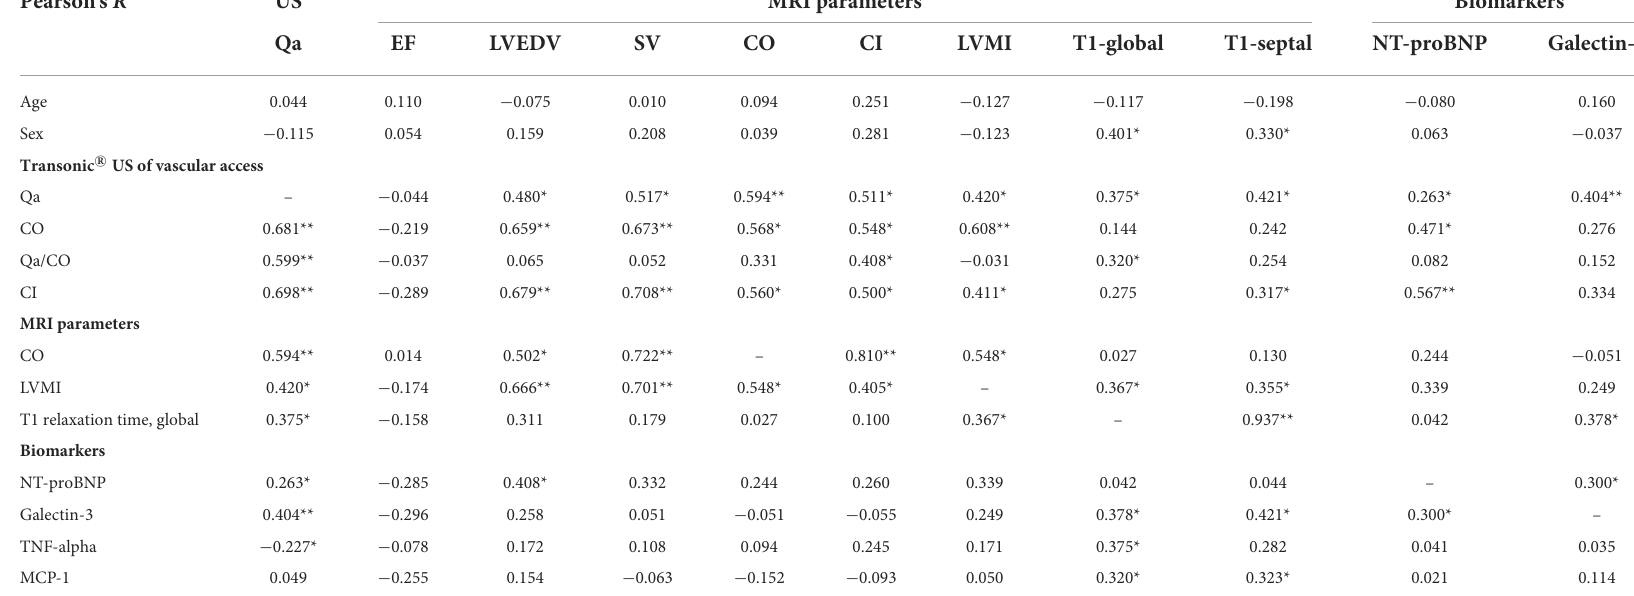
TABLE 3 Correlation between CMR imaging indexes, AVF flow and